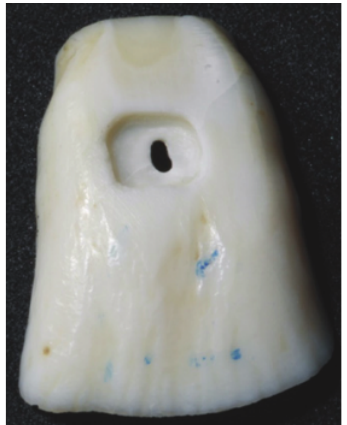
Figure 2: Illustration of adhesive failure mode.